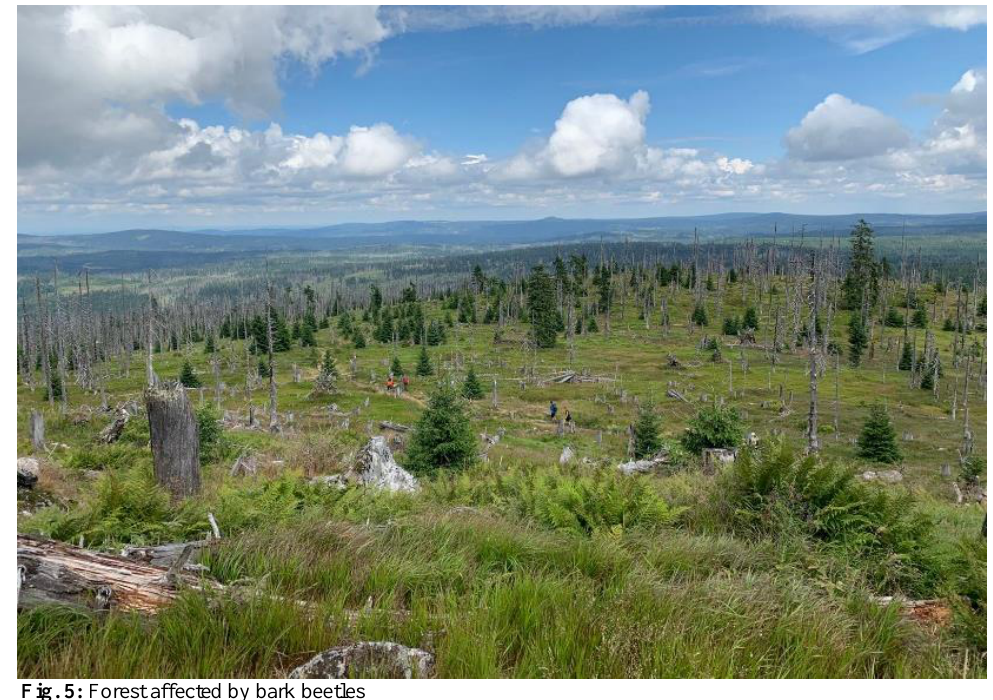
Fig. 5: Forest affected by bark beetles